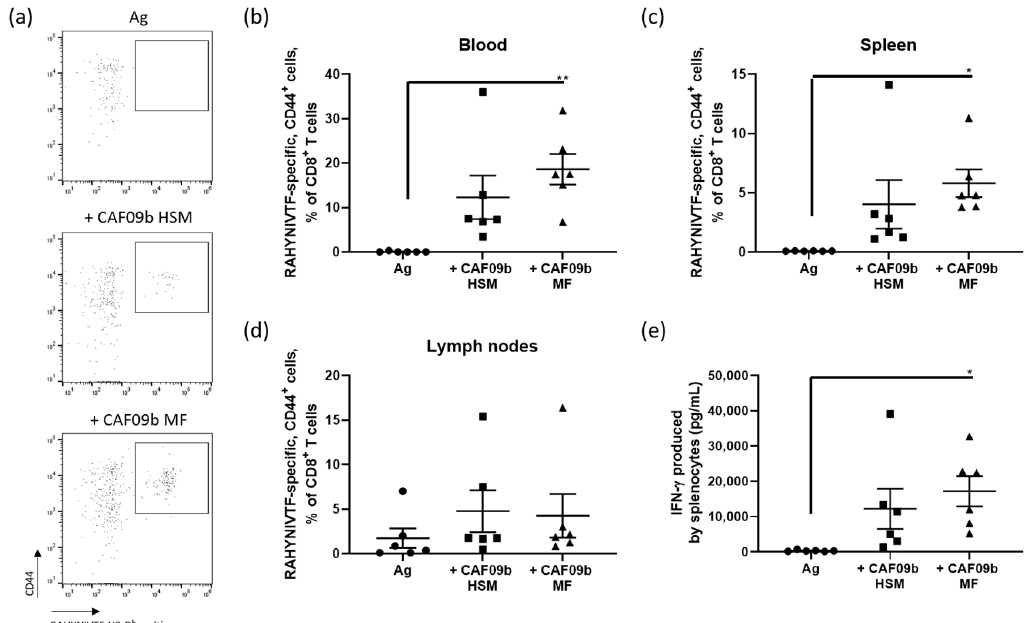
Figure 4. Evaluation of the CD8 + T-cell responses induced by CAF09b prepared by either the lipid film rehydration or microfluidics methods. Groups of six female C57BL / 6-mice were immunized intraperitoneally (i.p.) twice with two-week-intervals with 10 µ g / dose 15-mer peptide containing the HPV-16 E7 minimal epitope RAHYNIVTF either unadjuvanted or adjuvanted with CAF09b prepared by the high shear mixing (CAF09b HSM) or the microfluidics (CAF09b MF) methods. ( a ) The antigen-specific CD8 + T-cell responses (defined as CD19 − , CD4 − , CD8 + ) were analyzed as CD44 + , RAHYNIVTF-H2-D b -PE multimer + by flow cytometry, representative samples of the responses in each group in the blood. The analyses were performed in ( b ) the blood, ( c ) spleen, and ( d ) draining mediastinal and tracheobronchial lymph nodes. ( e ) Production of IFN- γ by splenocytes stimulated with RAHYNIVTF analyzed by ELISA. n = 6, bars represent mean ± SEM. * p ≤ 0.05, ** p ≤